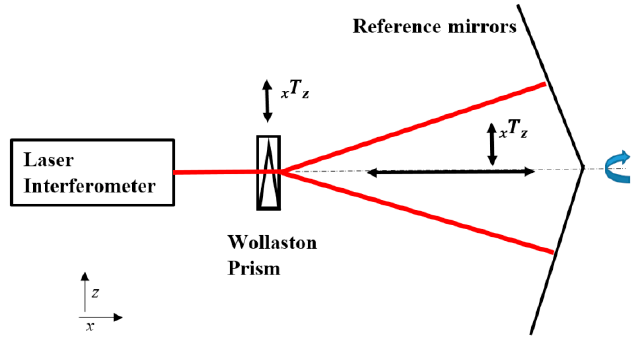
Figure 10. Straightness measurement optics.